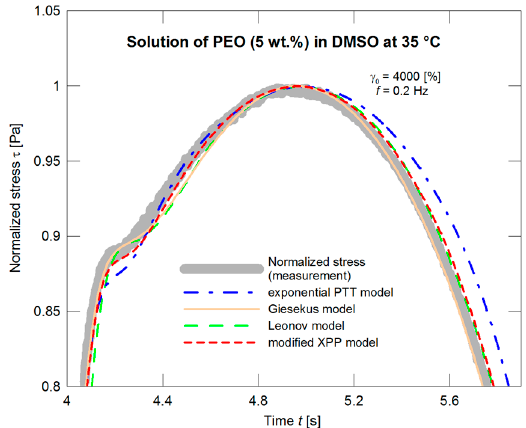
Figure 13. Optimization of the exponential PTT, Giesekus, Leonov, and modified XPP models with respect to the normalized stress amplitude, the detail with the “protrusion” region.